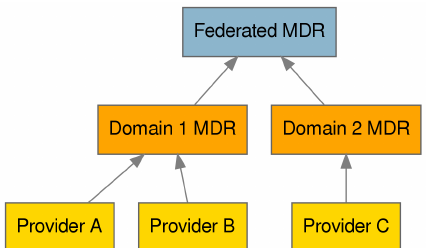
Figure 9. IoTCrawler federation architecture, showing regular and federated Meta-Data Repositories